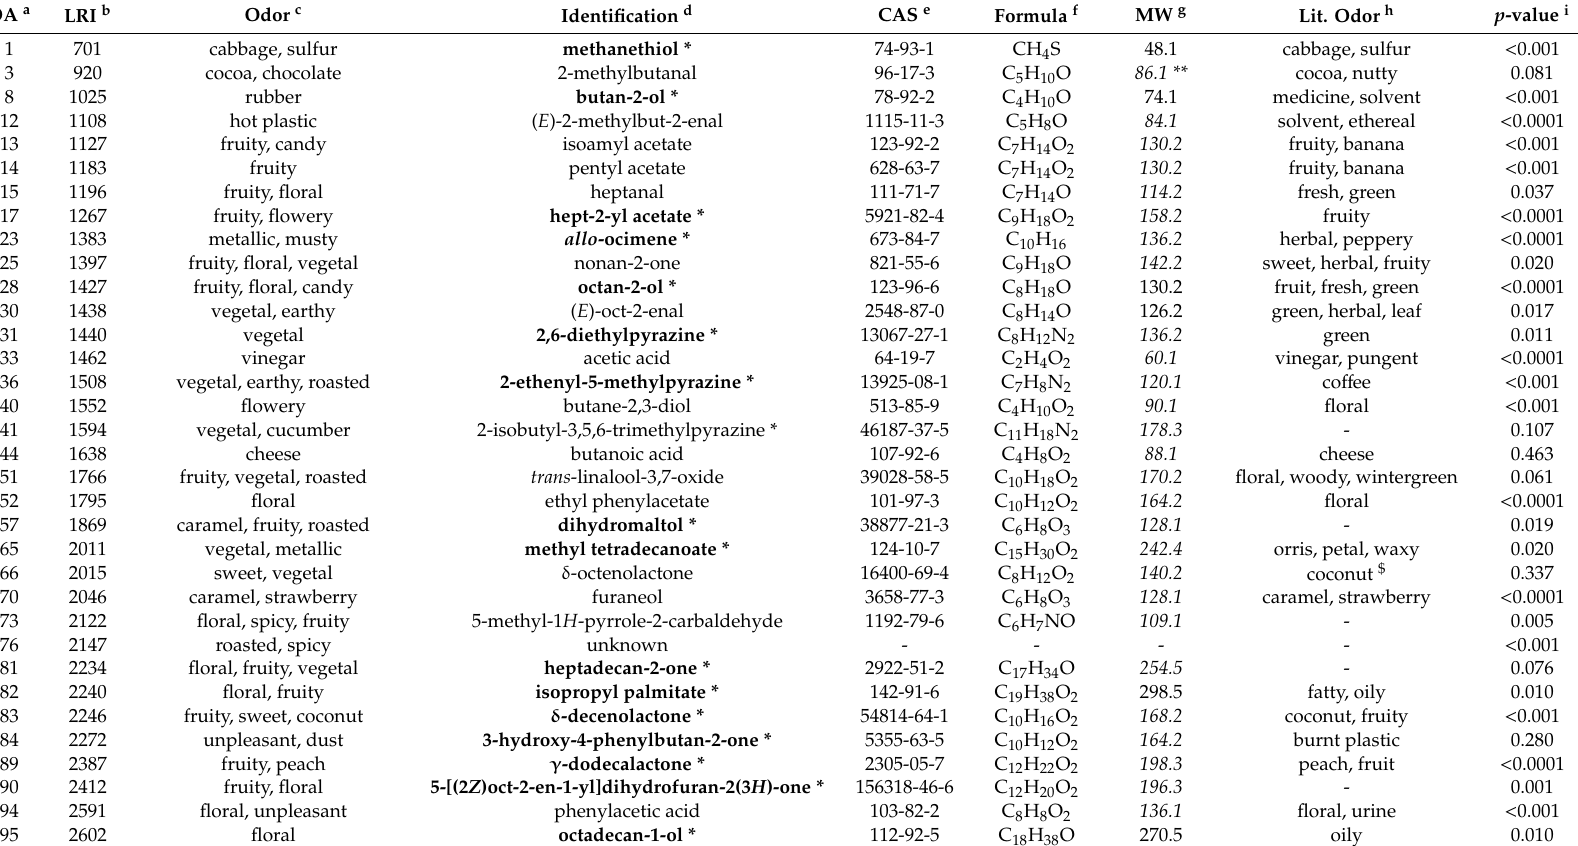
Table 2. Key discriminant aroma compounds that characterize the four sensory poles as determined in a cDFA GC-O analysis using a 50% discriminative threshold (see text for a complete explanation). a OA number, as in Table 1; b LRI on DB-FFAP, as in Table 1; c Odor attributes given by the panel; d Identification (refer to Table 1); e Chemical Abstracts Service registry number; f Mass formula; g Molecular Weight; h Pertinent odor attributes found in the databases VCF and The Good Scents Company (http: // www.thegoodscentscompany.com / ); i p -value of the Khi 2 test ( α = 0.05) obtained for the parametric test comparison of k proportions using the data of Table